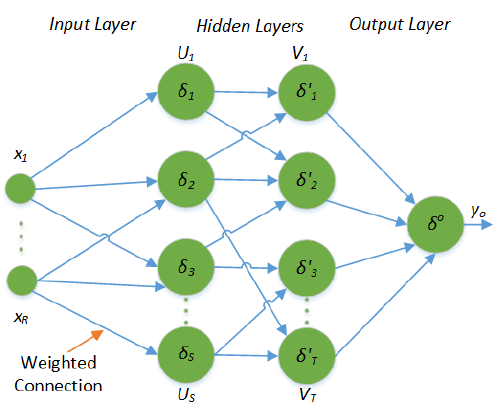
Figure 1. Basic structure of a fully connected artificial neural network